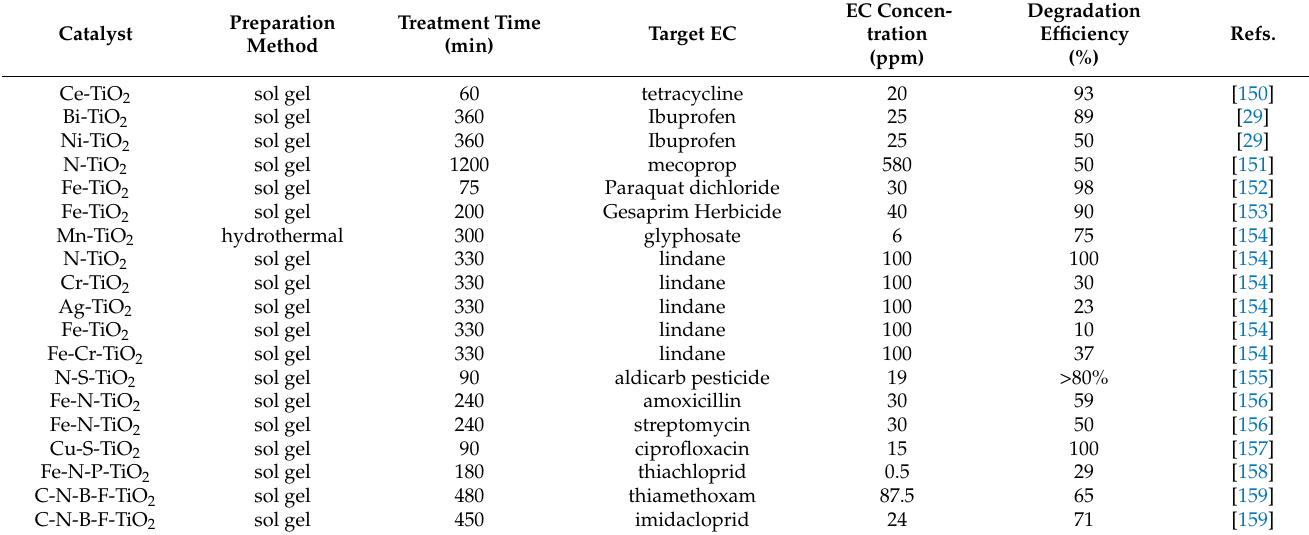
Table 3. List of doped and codoped catalysts used on visible light degradation of